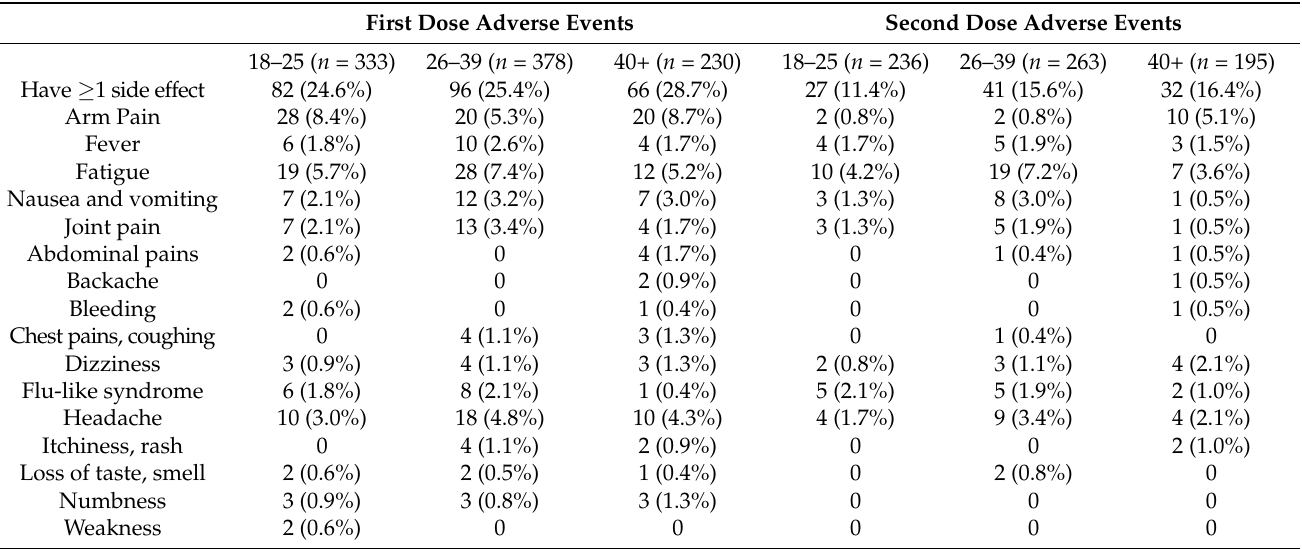
Table 4. Prevalence of adverse events after first and second vaccination doses by age group.